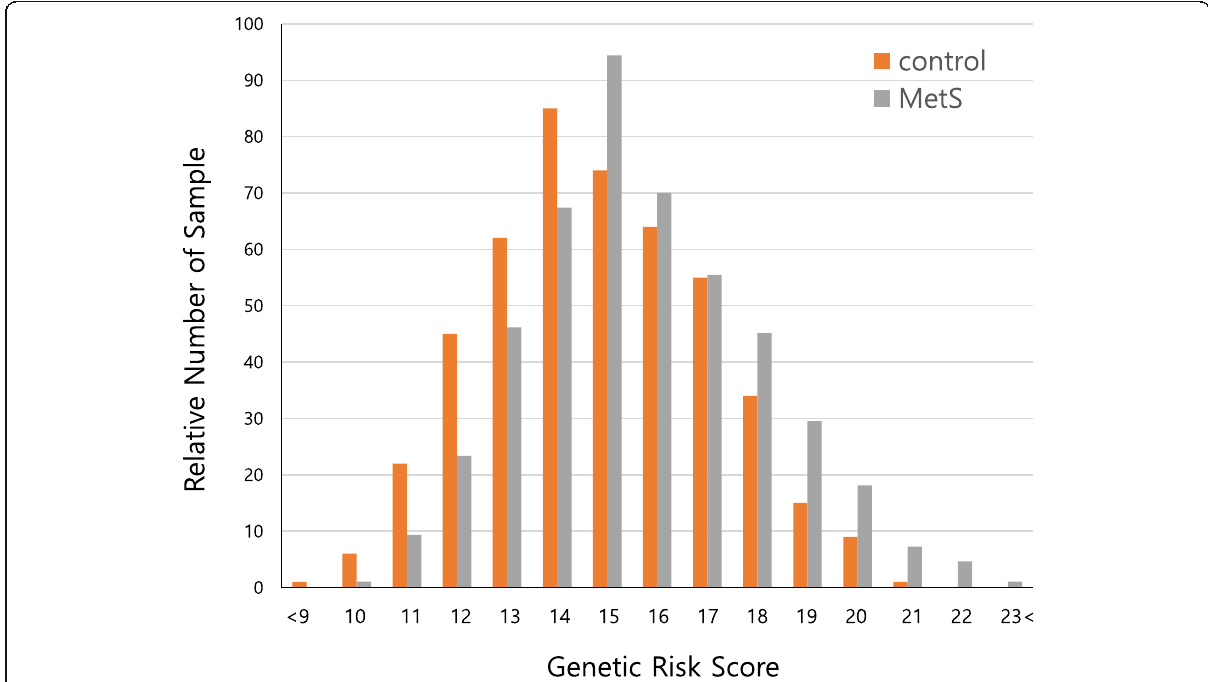
Fig. 3 Combined effect of risk alleles on MetS. On the x-axis, each genetic risk score (GRS) category was shown. The y-axis in the histogram indicates the relative number of female subjects in each GRS category. Grey and orange bars represent MetS cases and controls,